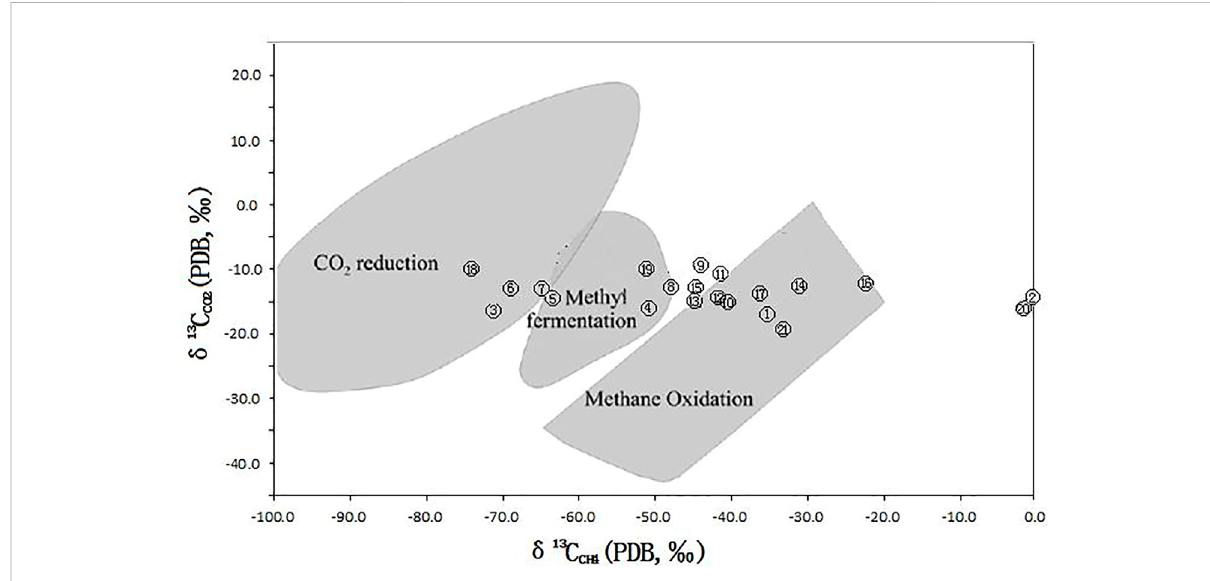
FIGURE 5 Relationship diagram of 13 C CH4 − δ 13 C CO2 (base fi gure according to Woltemate et al. (1984)).